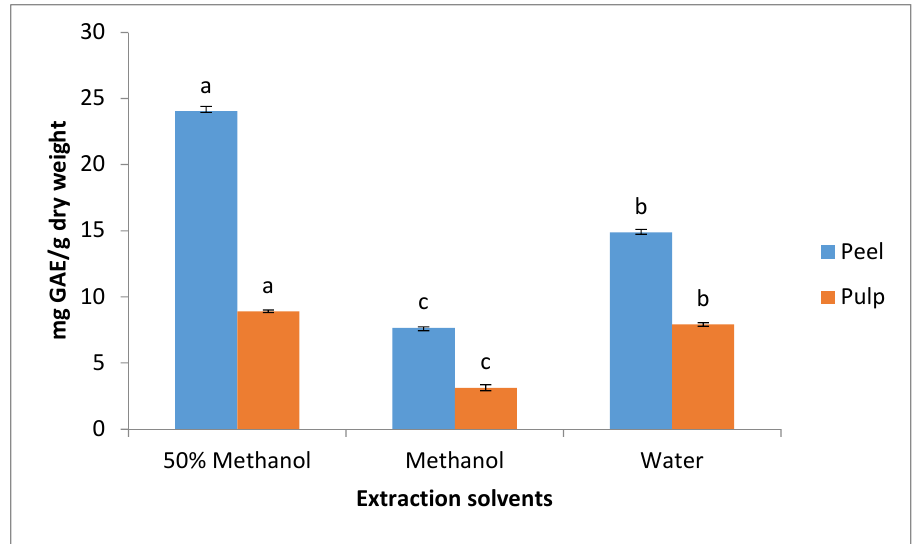
Figure 1. The total polyphenol content of beetroot peel and pulp. The different letters on bars show the significant differences among the extracts for peel and pulp individually ( p < 0.05).